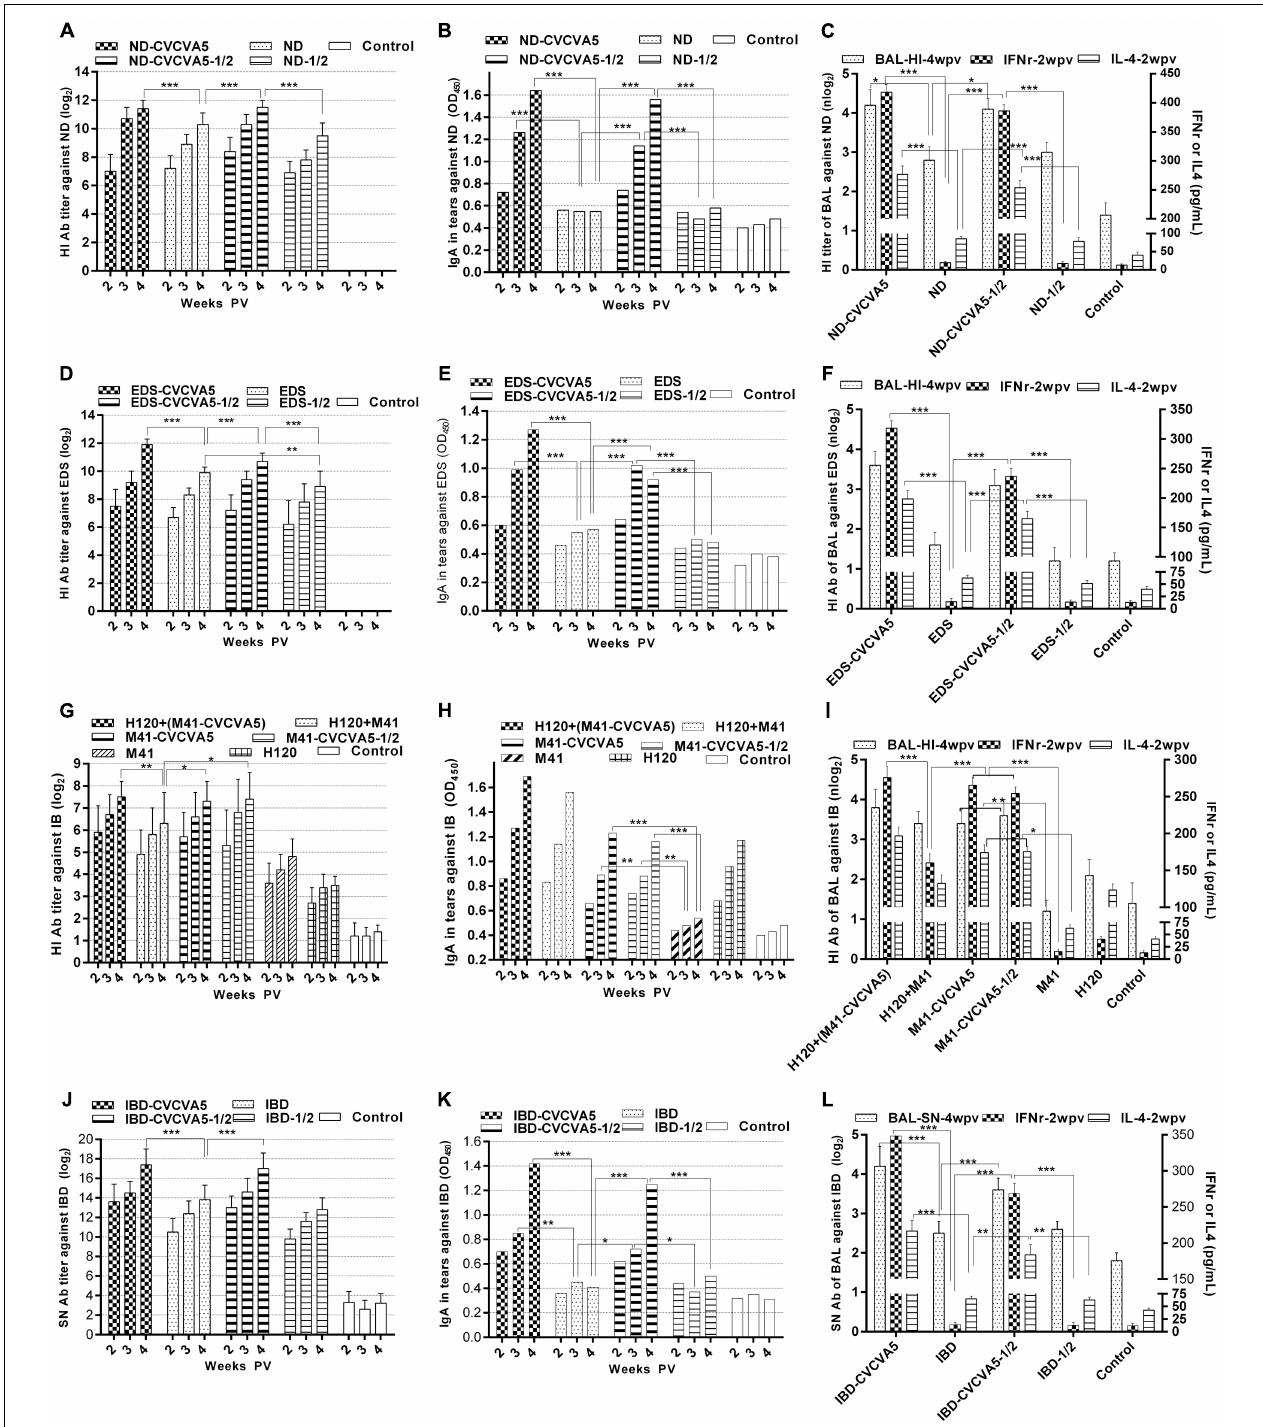
FIGURE 1 | Antibody titers against virus antigen of monovalent vaccines. Groups of 3 days old age of SPF chickens ( n = 20) were vaccinated with the following vaccines. ND-CVCVA5, one dose of CVCVA5 adjuvanted ND vaccine. ND, one dose of ND vaccine without CVCVA5. ND-CVCVA5-1/2, half-dose of CVCVA5 adjuvanted ND vaccine. ND-1/2, half dose of ND vaccine (A) . The name of EDS (D) and IBD (J) vaccines groups were analog to those of ND vaccines. H120+(M41-CVCVA5) and H120+M41, the chickens primly vaccinated one dose of live H120, and boosted with one dose of M41 with or without CVCVA5 with 7 days intervals (G) . Mucosal antibody levels in tears of pooled samples for ND (B) , EDS (E) , IB (H) , and IBD (K) . The HI antibody titer in BAL ( n = 3) at 4 weeks PV (weeks post vaccination), and IFN γ and IL-4 levels in serum ( n = 5) at 2 weeks PV for ND (C) , EDS (F) , IB (I) , and IBD (L) . ∗ P < 0.05, ∗∗ P < 0.01, ∗∗∗ P < 0.001.